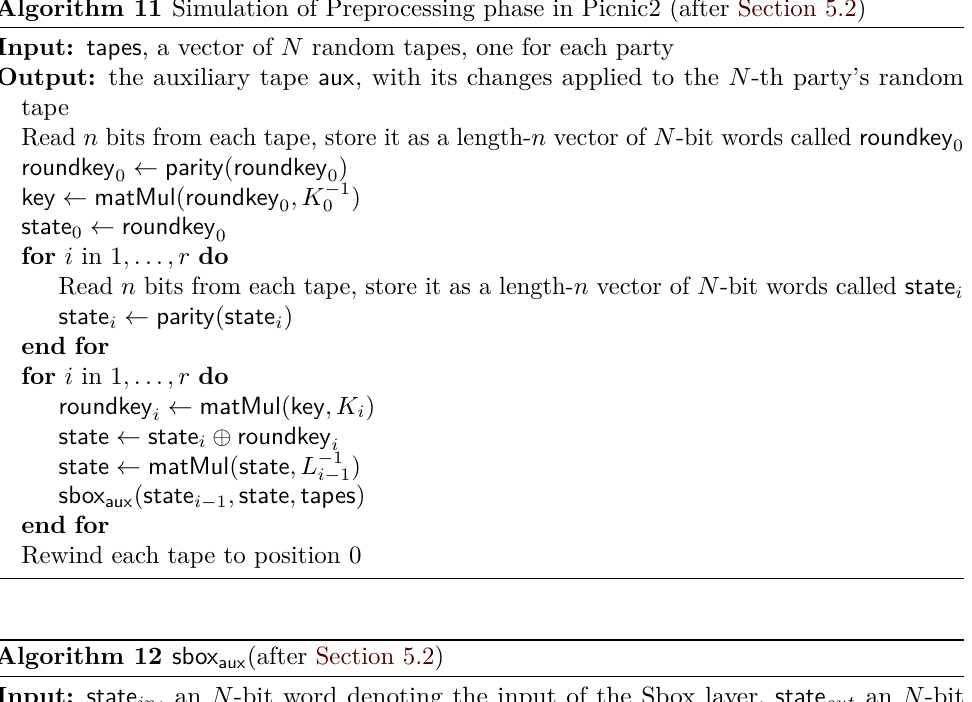
Algorithm 11 Simulation of Preprocessing phase in Picnic2 (after Section 5.2)